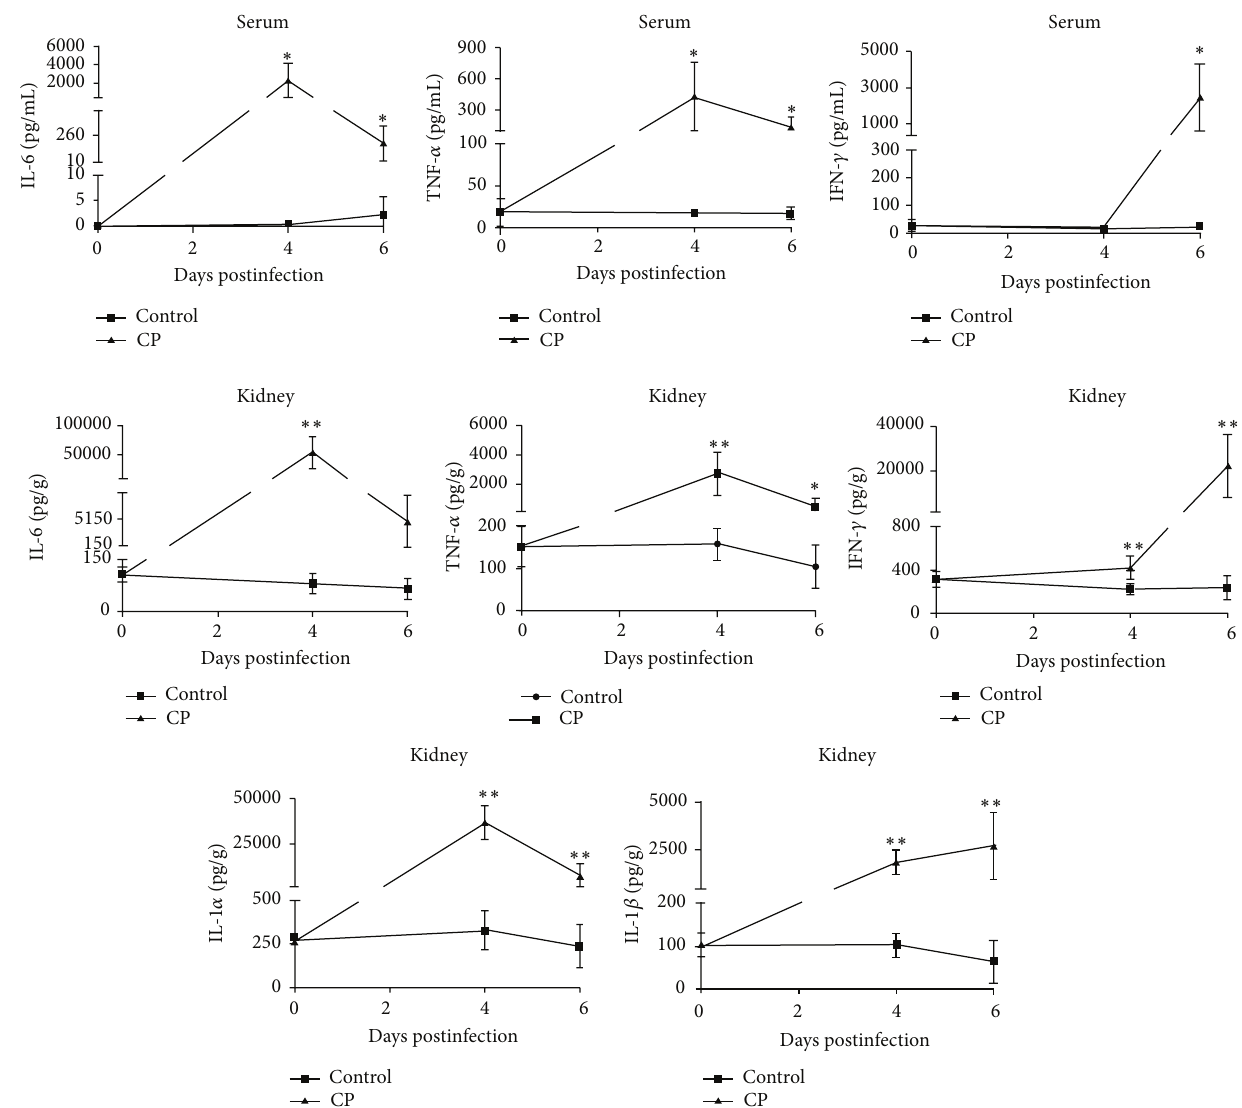
Figure 7: Dynamic changes of serum and renal cytokines. Serum IL-6, TNF- 𝛼 , and IFN- 𝛾 and renal IL-6, TNF- 𝛼 , IFN- 𝛾 , IL-1 𝛼 , and IL-1 𝛽 presented significant increases during the infection